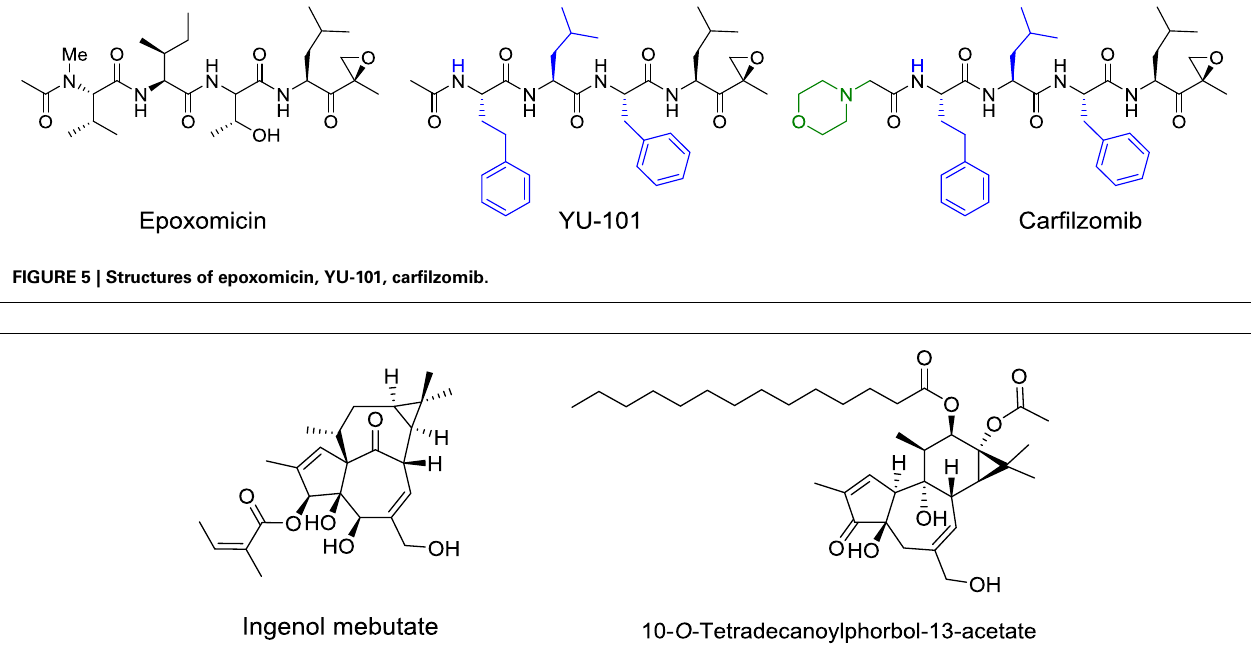
FIGURE 6 | Structures of 12- O -tetradecanoylphorbol-13-acetate and ingenol mebutate.